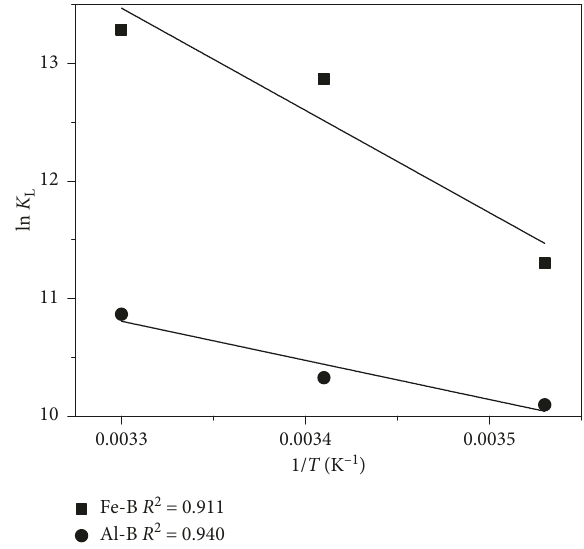
Figure 14: Plot ln K versus 1/ T for the determination of ther- L modynamic parameters. Table 7: Thermodynamic parameters for the As(V) adsorption onto Fe-B and Al-B materials.